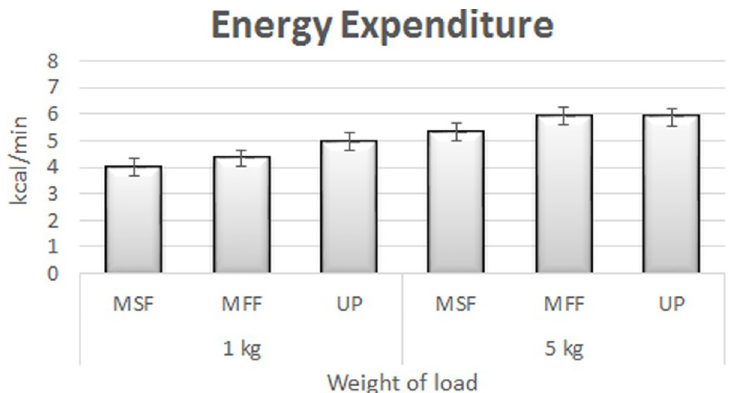
Fig 4. The mean and standard error of energy expenditure based on the lifting load (MSF = Metronome Task-slow initial frequency; MFF = Metronome Task-fast initial frequency; UP = unpaced task).